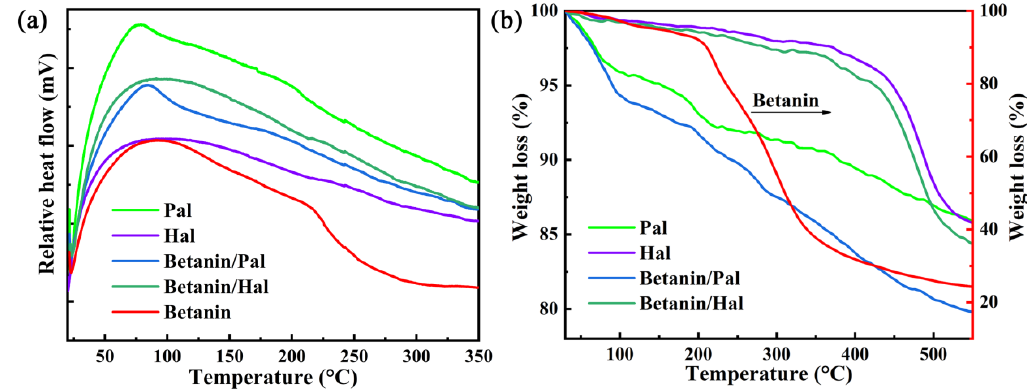
Figure 5. ( a ) DSC and ( b ) TGA curves of the raw clay minerals and hybrid materials.